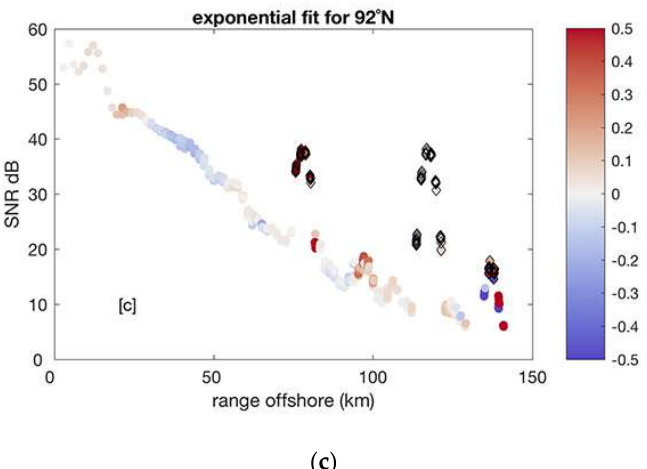
Figure 5. Example of the effects of the proposed 1-D QC methodology on radial velocity map from RRK HFR station along one radial beam: ( a ) cubic 1-D fit; ( b ) quadratic 1-D fit; ( c ) exponential decay 1-D fit. Units are km for offshore range, dB for SNR, and m/s for radial velocity (color scale).